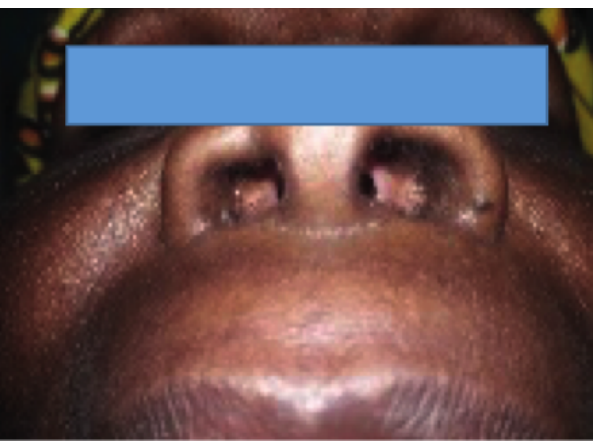
Figure 4. Cicatricial retraction of the nasal